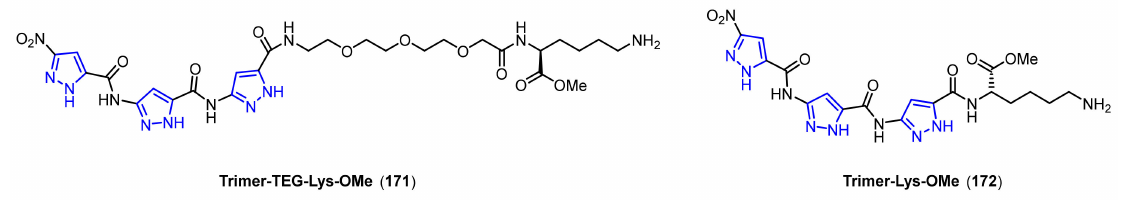
Figure 9. Chemical structures of pyrazole-containing A β 42 inhibitors.